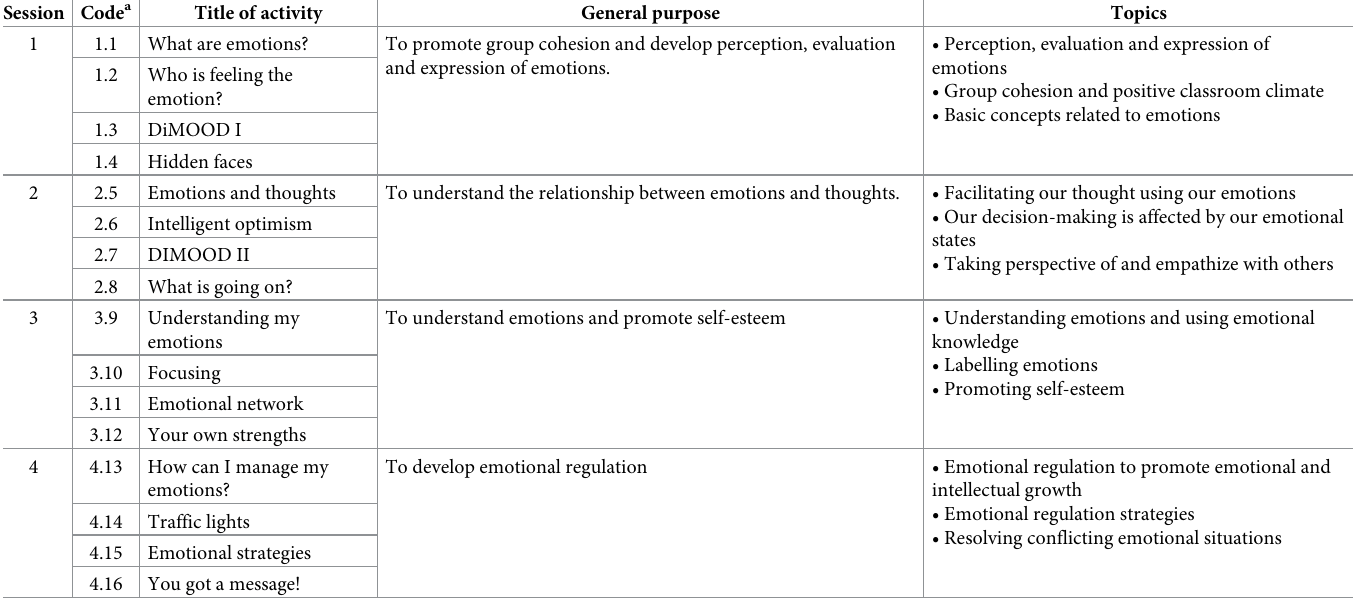
Table 1. Sessions, activity code, title of activities, general purpose, and topics in the programme. Session Code